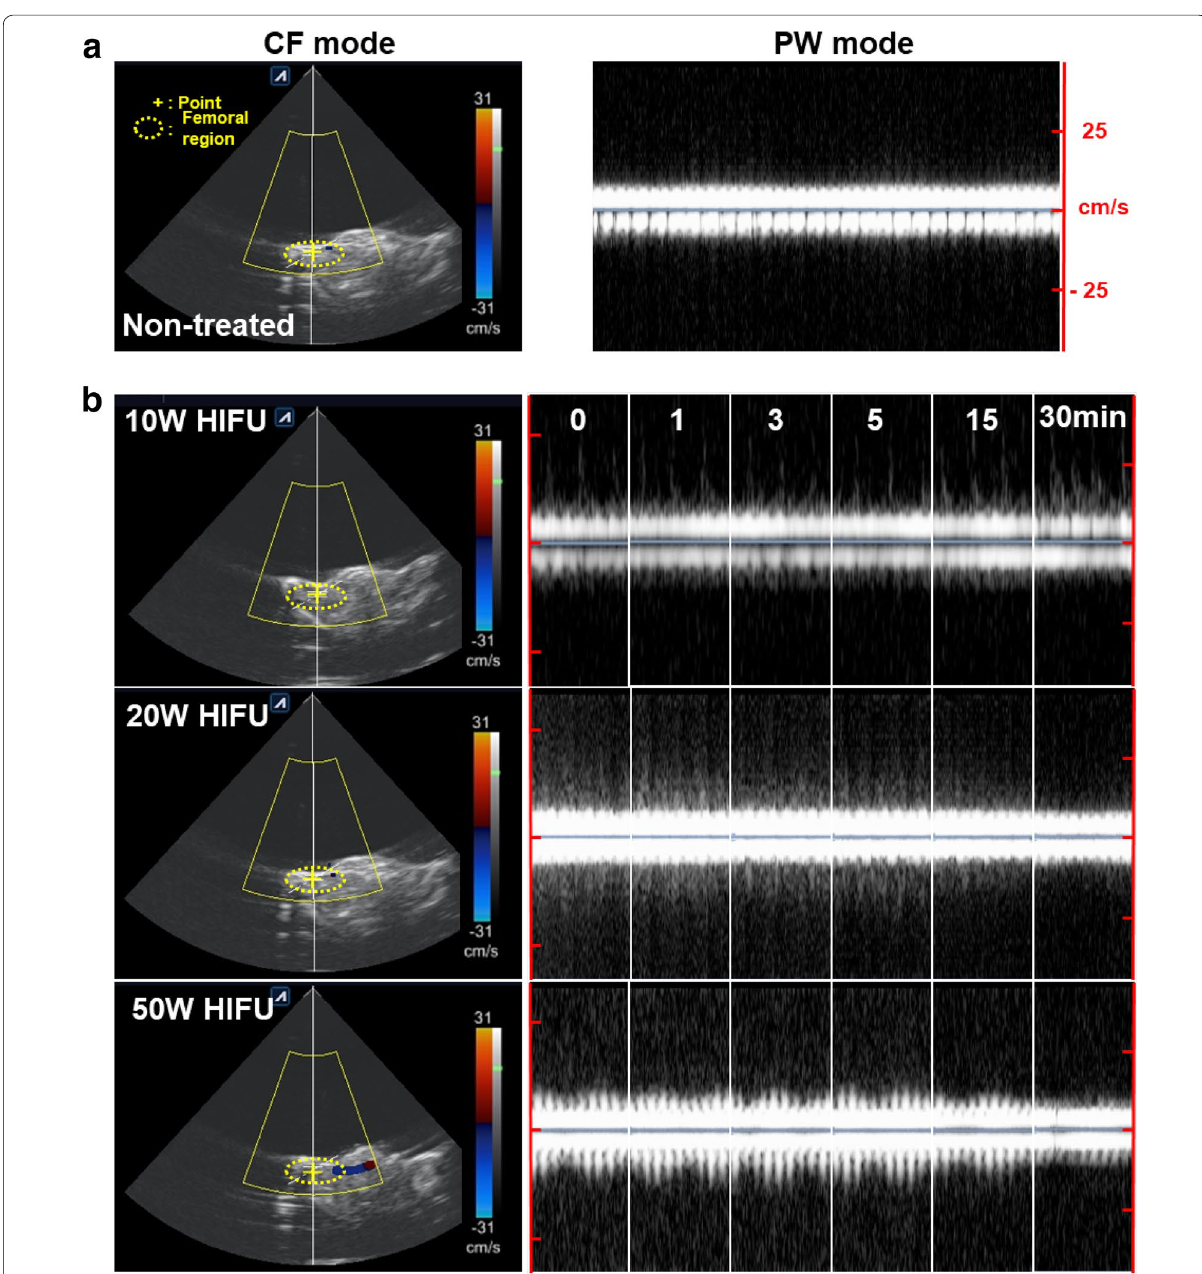
Fig. 2 pHIFU-mediated blood flow enhancement. Color-flow Doppler ultrasound image and pulsed-wave Doppler image of a non-treated (0 W pHIFU) and b 10, 20, and 50 W pHIFU-treated femoral tissue. Yellow dot circles indicate the femoral vessel